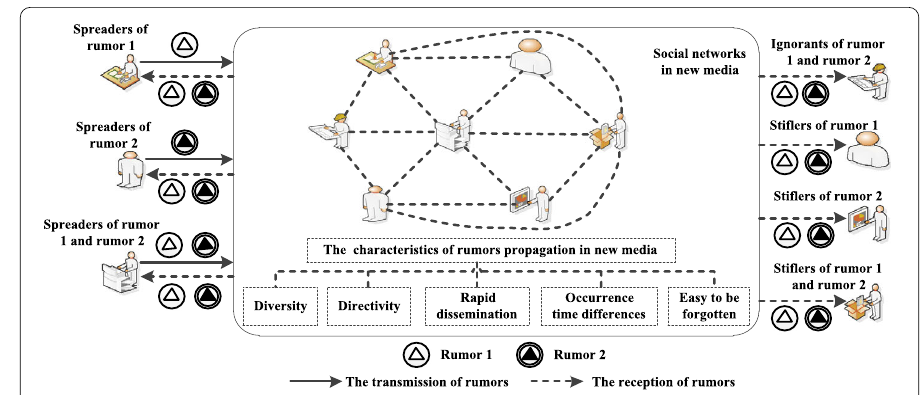
Figure 3 Behaviors of different individuals in new